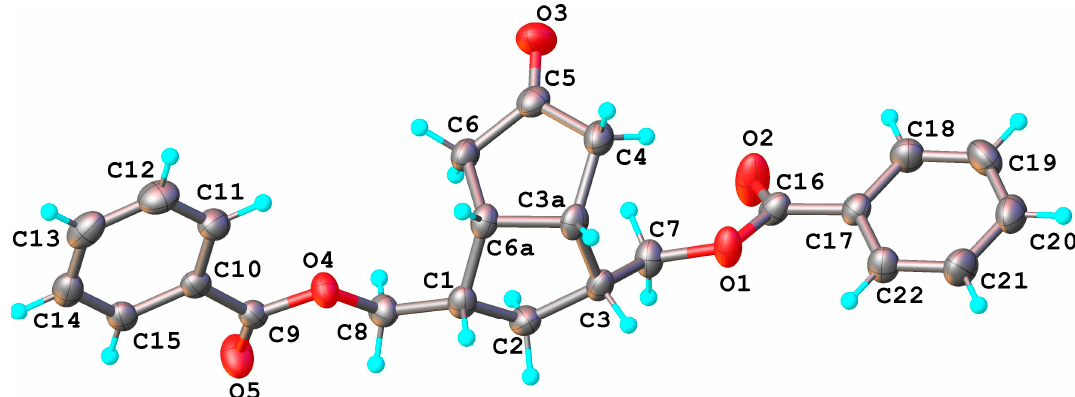
Figure 5. X-ray molecular structure of symmetric ketone bis-benzoate compound 5 with atom labeling scheme and thermal ellipsoids at 50% probability level.